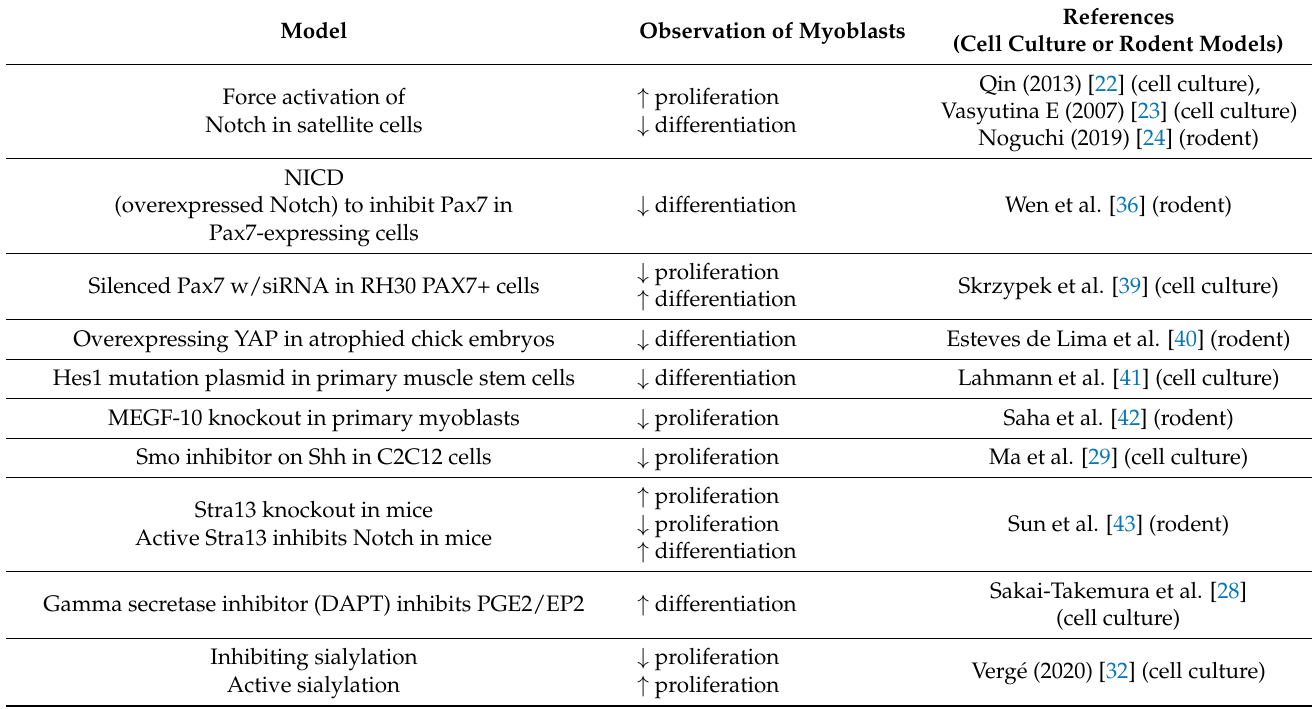
Table 1. Summary of recent evidence on models that investigated Notch’s role in myoblast proliferation and differentiation.